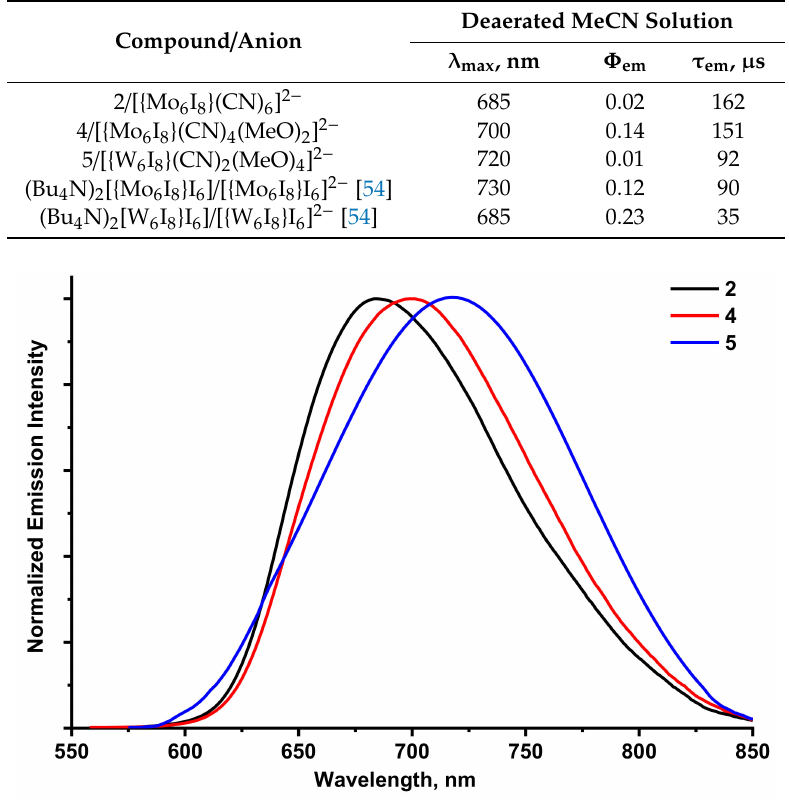
Figure 7. Normalized emission spectra of compounds 2 , 4 and 5 in acetonitrile